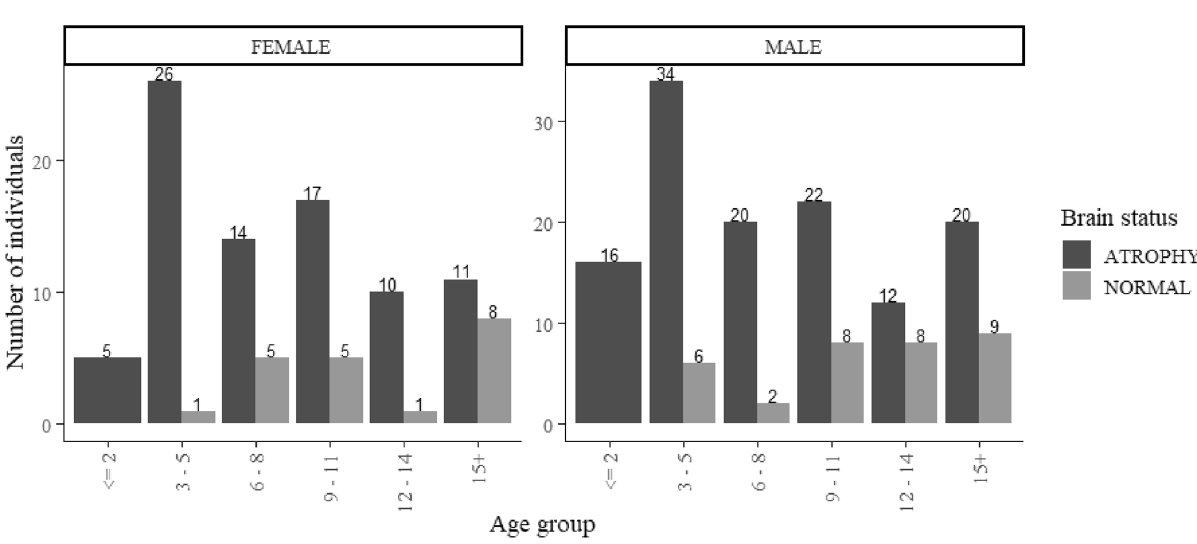
Figure 5. Participants’ age and gender